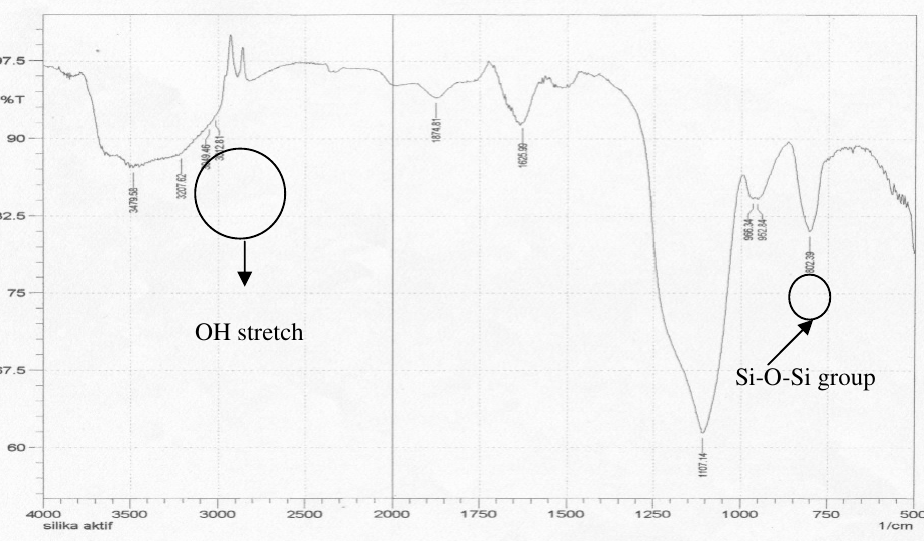
Figure 1. FT-IR spectrum of activated